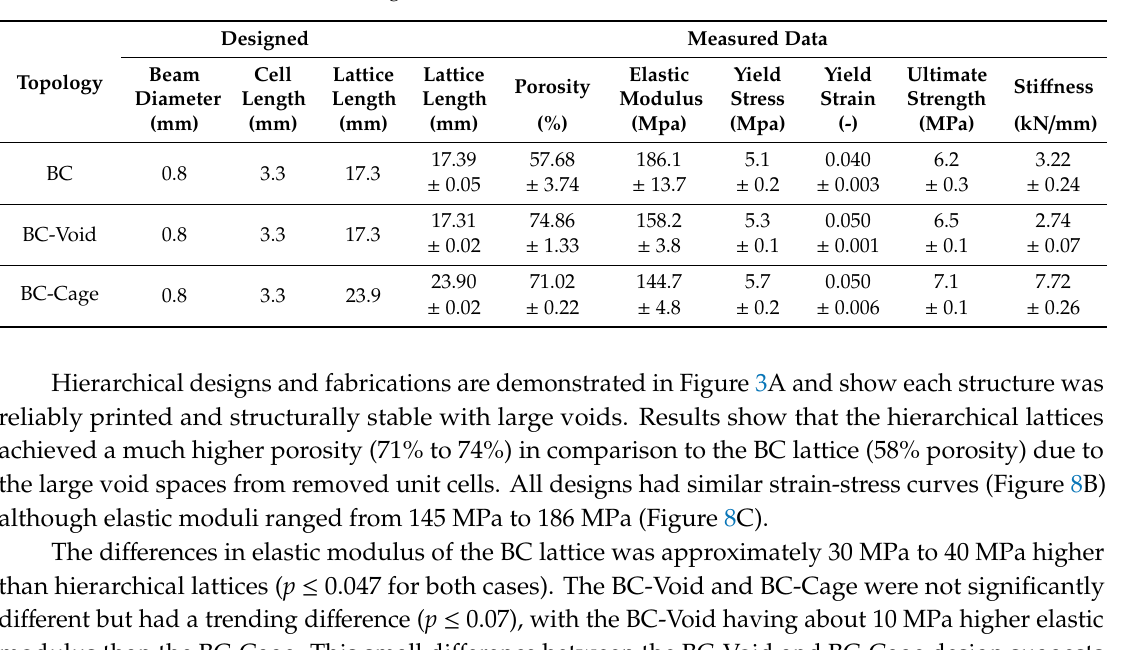
Table 4. Design and measurements for hierarchical